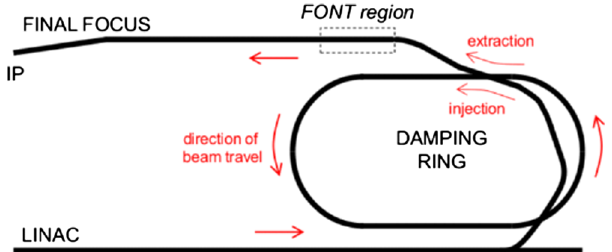
FIG. 5. Luminosity versus beam-beam deflection angle. The red line is a cubic spline interpolation.